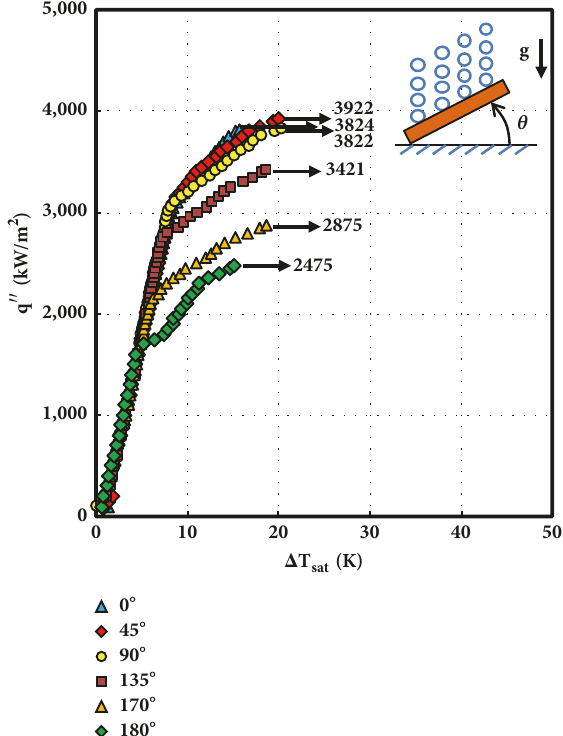
Figure 10: Boiling curves of HTCMC with various orientation angles at 30K